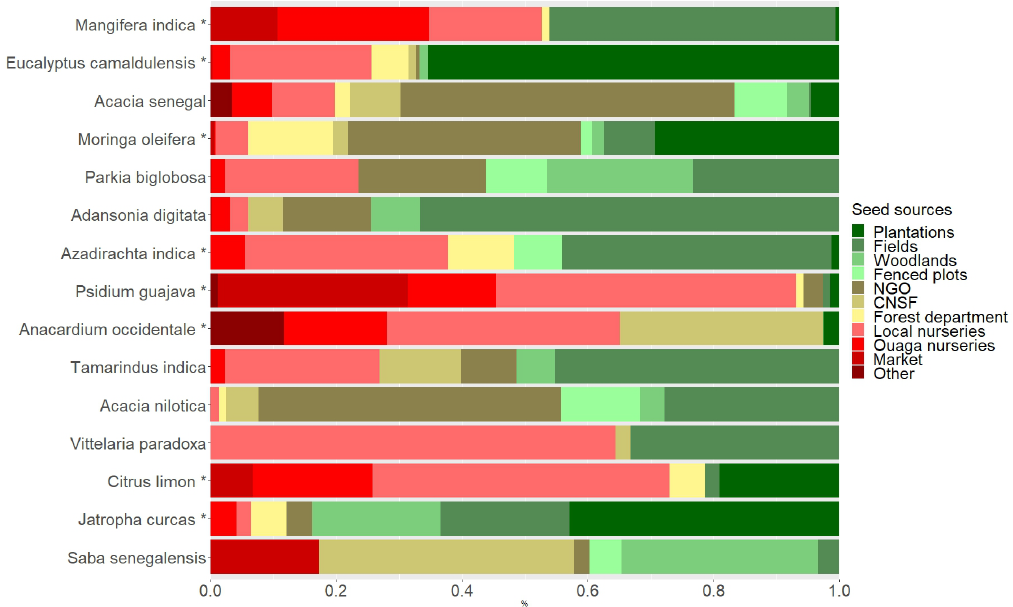
Figure 6. Barplots representing the proportions of the seeds coming from the different types of sources for the 15 most frequently planted